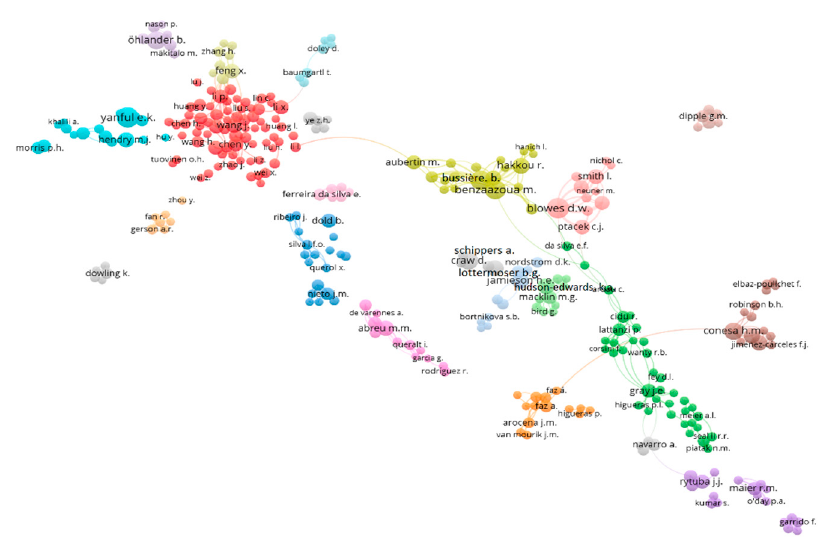
Figure 4. Cooperation based on co-authorship between authors.